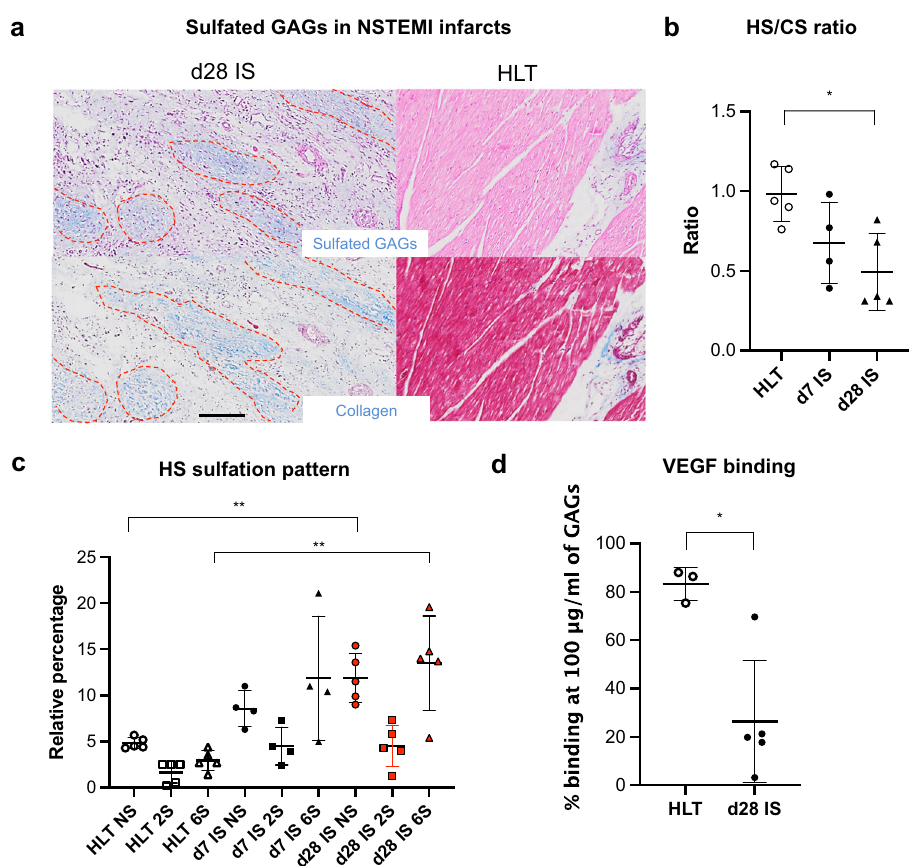
n =4 d7 and n =5 d28 animals. d VEGF binding capacity of extracted total GAGs (at 100 μ g/ml) between HLT and d28 IS. n =3 HLT and n =5 d28 animals. Kruskal- Wallis with Dunn ’ s multiple comparisons test in ( b , P =0.02 HLT vs. d28 IS) and ( c , P =0.002 HLT NS vs. d28 IS NS, P =0.008 HLT 6S vs. d28 IS 6S), two-tailed Mann – Whitneytest( P =0.036)in( d ).* P <0.05,** P <0.01.Dataareplottedshowing the mean and standard deviation in ( b – d ). Source data are provided as a Source Data fi